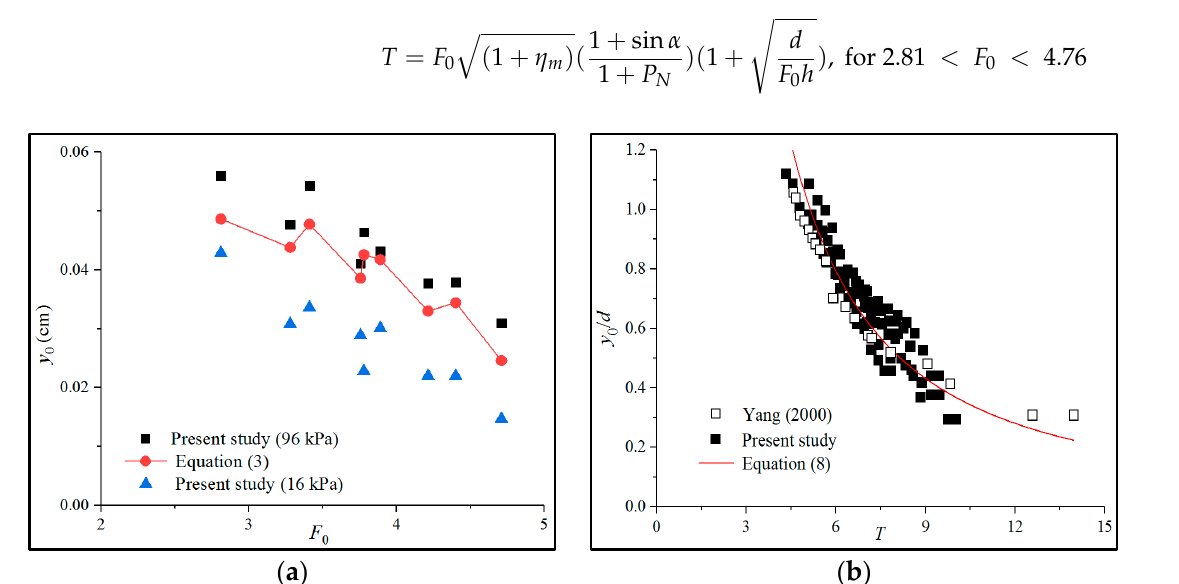
Figure 6. Measurement and calculation data of y 0 . ( a ) Experimental and calculated values of backwater depth; ( b ) comparison between Equation (8) with experimental data.